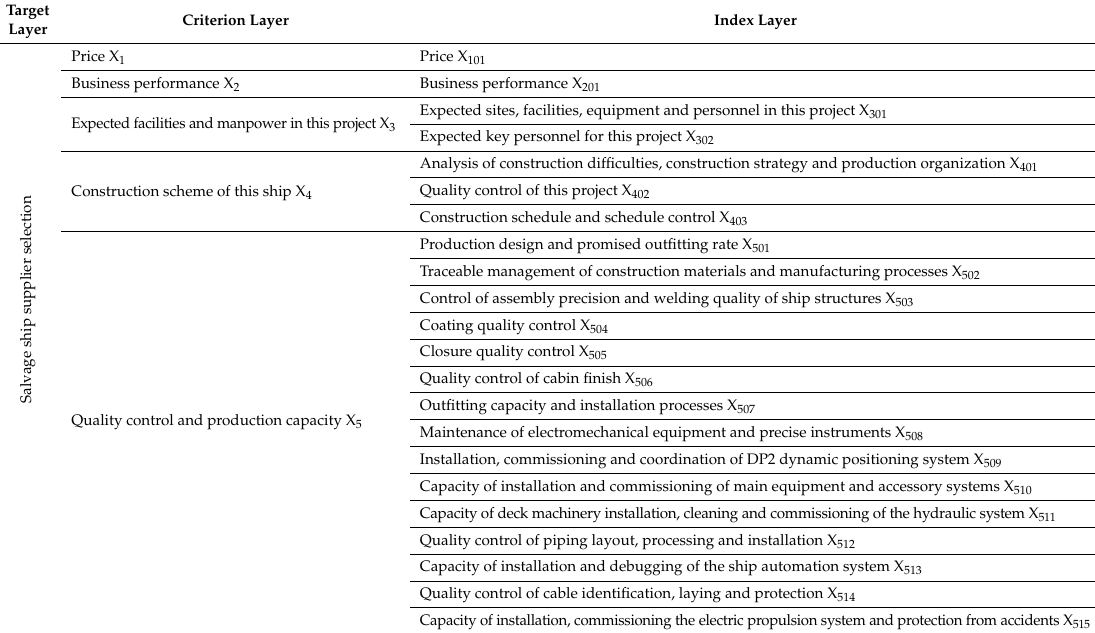
Table 1. Indicator System of Salvage Ship Supplier